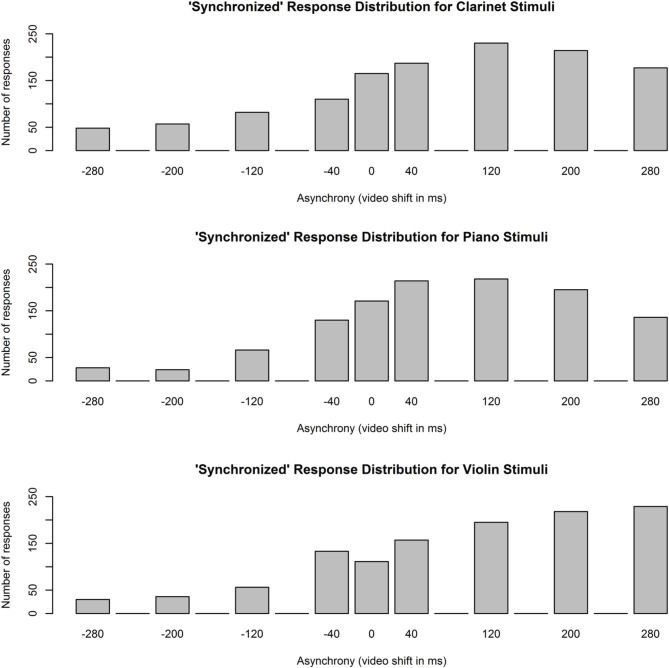
Distributions of “synchronized” responses for clarinet, piano, and violin stimuli. Data have been pooled across expertise groups and have not been changed to reflect the adjustment that was subsequently applied to PSS values. At positive asynchronies, audio lagged behind video; at negative asynchronies, video lagged behind audio. Only asynchrony values with bars and labels were included in the experiment; empty bins correspond to delays that were not tested.